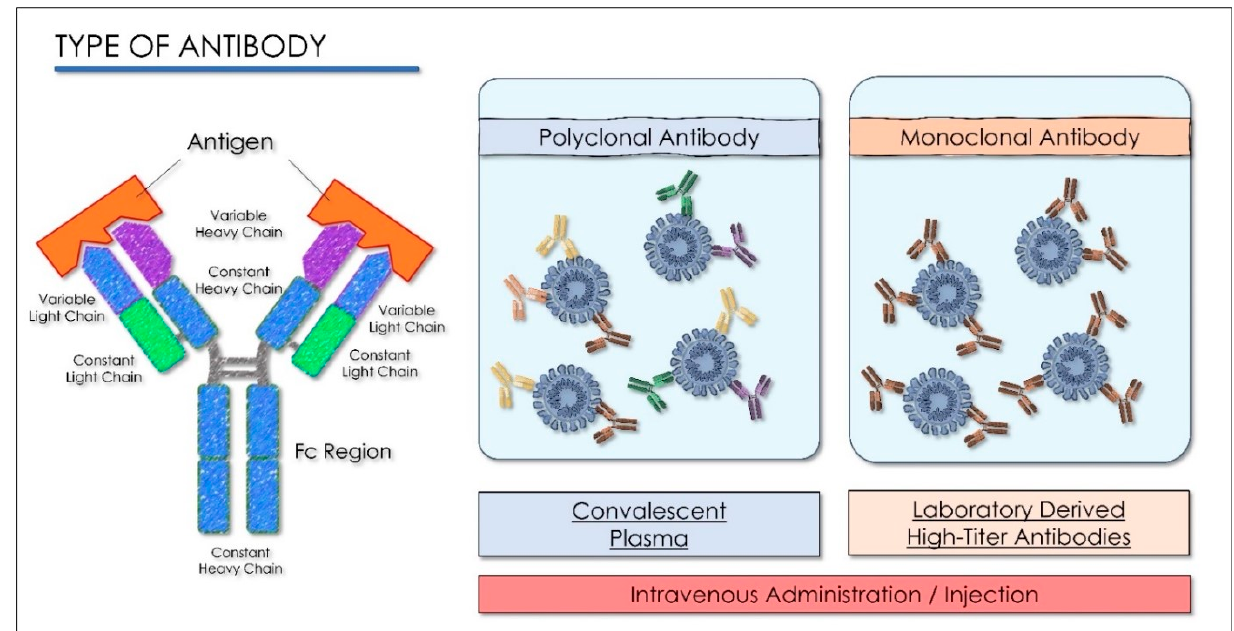
Figure 3. Details of polyclonal/monoclonal characteristics and administration protocols.